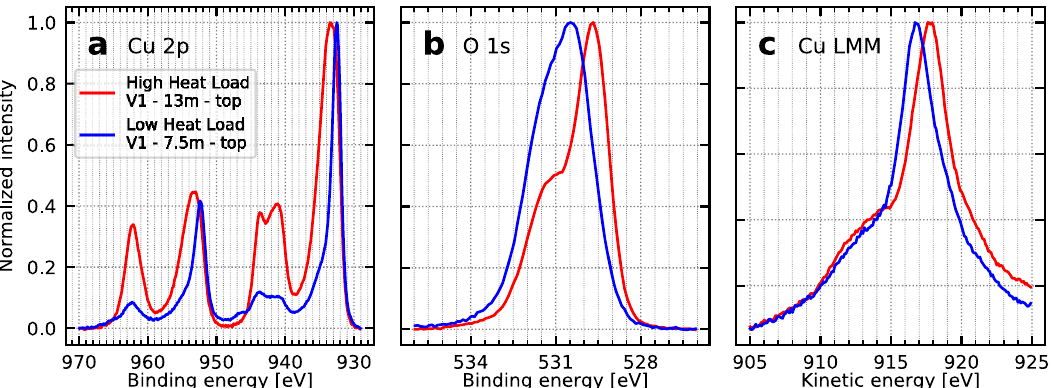
Fig. 5 Surface chemistry of beam screens as extracted. X-ray photoelectron spectroscopy (XPS) core level spectra of a Cu 2p, b O 1s, and c Cu LMM excitations for the top sides of V1 beam screen sections in the fi eld region of the High (red) and Low (blue) Heat Load dipoles. The intensity of the spectra is normalized to its maximum, after background subtraction.